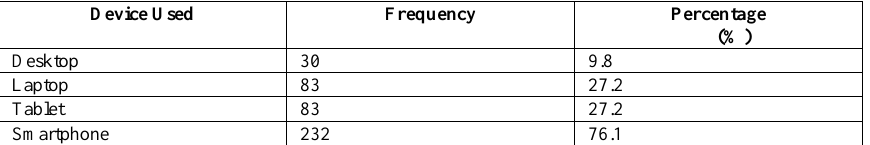
Table 6. Teacher Responses on ICT Device Use in the Past One Month